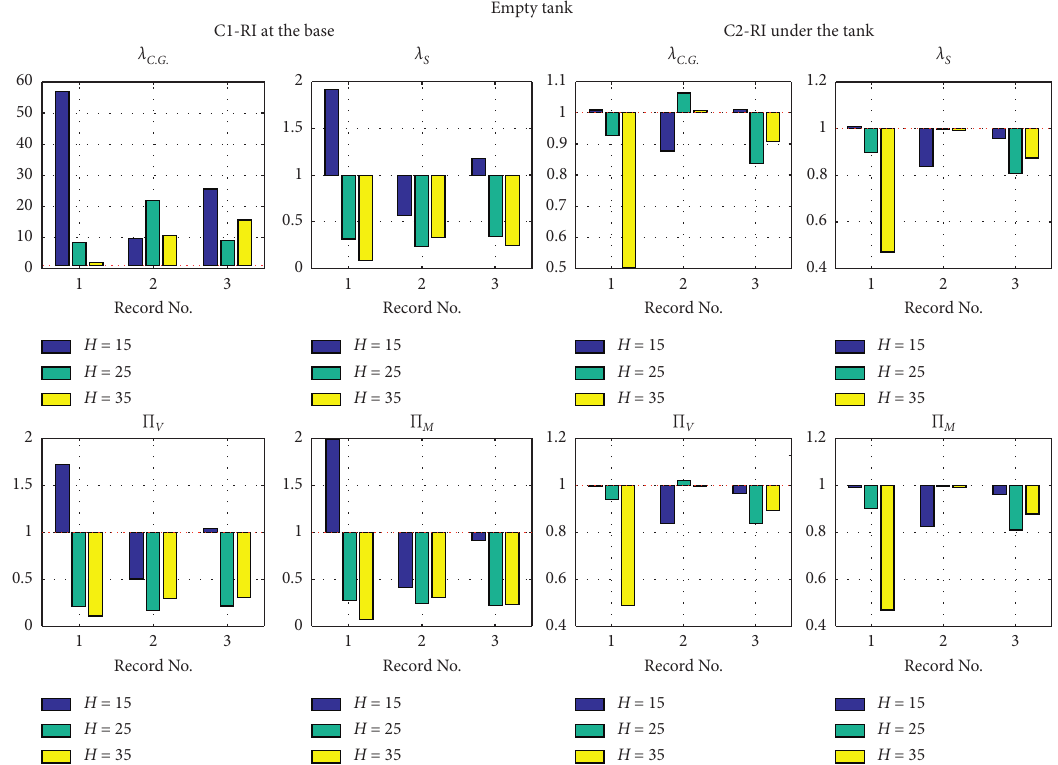
Figure 21: Performance of the prototype structures with “empty tank” and various “shaft heights” (15, 25, and 35